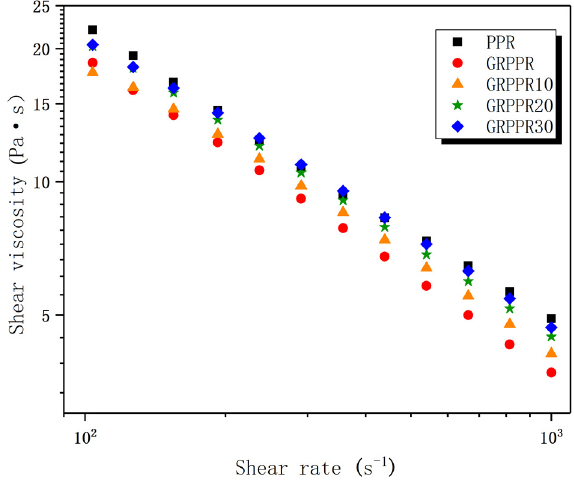
Figure 3. Shear viscosity versus shear rate for various materials measured at 220